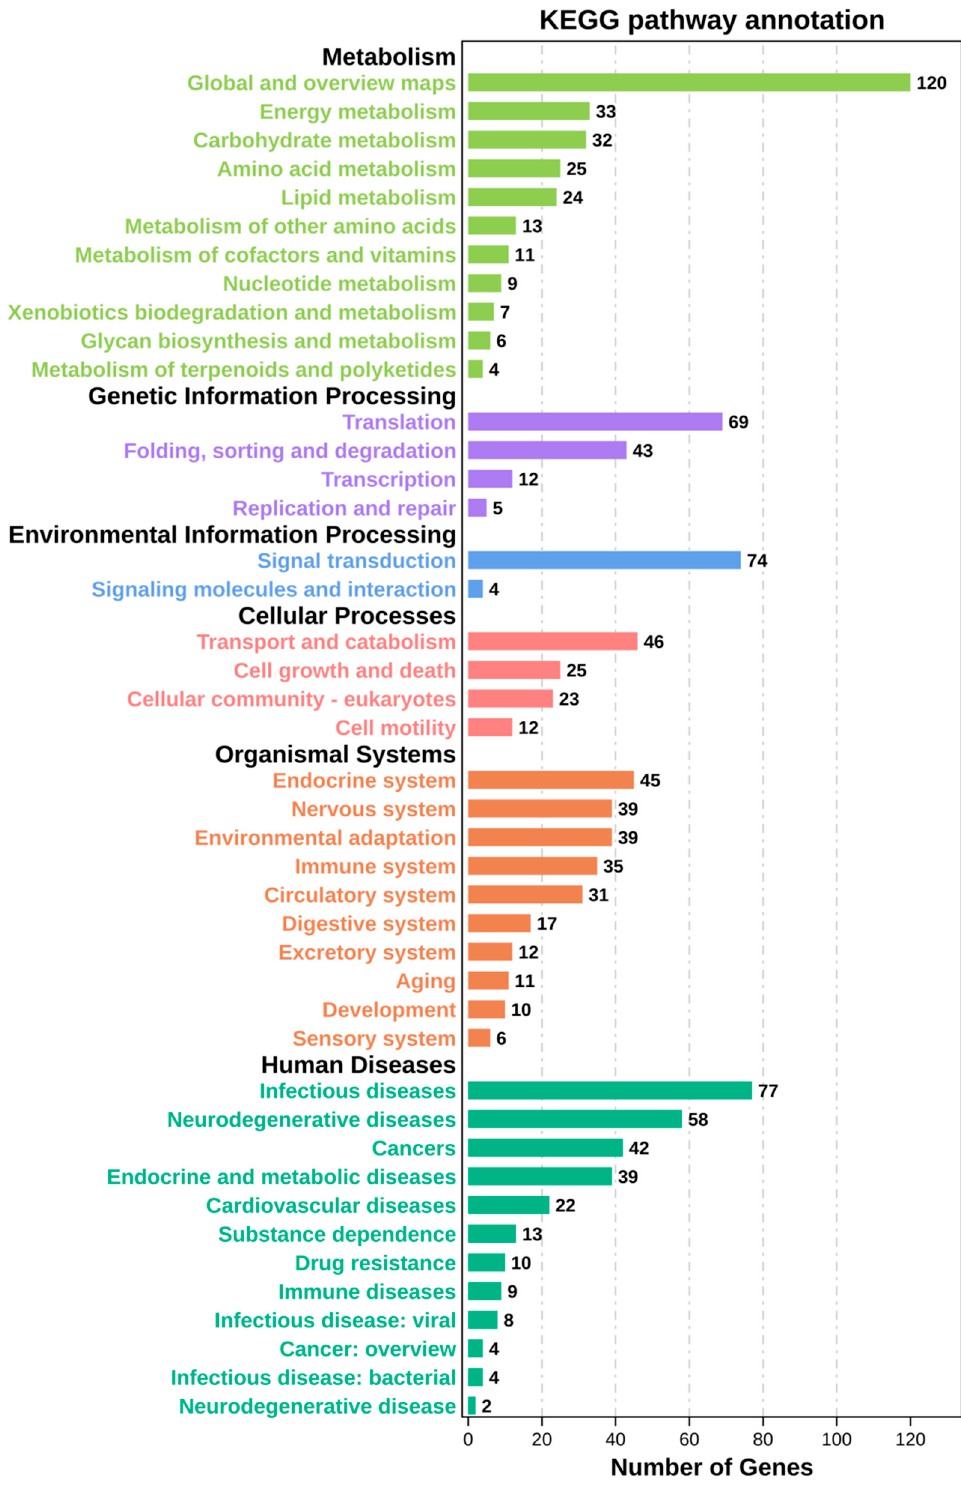
Figure 7. KEGG analysis on trend 8. The form and contents of the chart are in Figure 6. In trend 8, most genes are in the global and overview